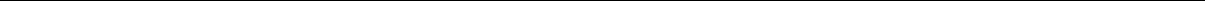
Fig. 2 Mip neurons in the CNS. a – c Mip neurons in a 4-day-old virgin female bearing a Mip-GAL4, UAS-mCD8-EGFP , b Mip 6.0 -GAL4, UAS-mCD8-EGFP and c Mip-GAL4, Mip6.0-GAL80, UAS-mCD8-EGFP stained with anti-GFP (green) and anti-nc82 (magenta) or anti-GFP ( green ) and anti-Mip (magenta) antibodies. The left schematic shows anti-Mip and EGFP-positive neurons (closed circles). The right schematic includes EGFP neurons that lack anti-Mip labelling (open circles). In the left schematic, dotted black circles group anti-Mip neuron classes. Dotted red circles indicate groups that lack complete labelling of Mip neuron(s), compared with Mip-GAL4 . Green shading in the schematic in b indicates a large number of uncounted EGFP-positive cell bodies. SAM superior anterior medial, SPL superior posterior lateral, IAM inferior anterior medial, ALS antennal lobe superior, SGS subesophageal superior, CA central anterior, ICLI inferior contralateral interneurons, SGI subesophageal inferior, LMIo lateral MIP-IR optic lobe, VMT1 ventral medial thoracic 1, VMT2 ventral medial thoracic 2, VMT3 ventral medial thoracic 3, vAL ventral lateral abdominal. Scale bars, 50 μ m. d Mating frequencies of virgin females of the indicated genotypes, scored as the percentage of females that copulate within 1 h. e Re-mating frequencies of mated females. The numbers in parentheses indicate n . NS indicates non-signi fi cance ( P > 0.05); *** P < 0.001 for comparisons against both controls (grey bars); Chi-square test d ,